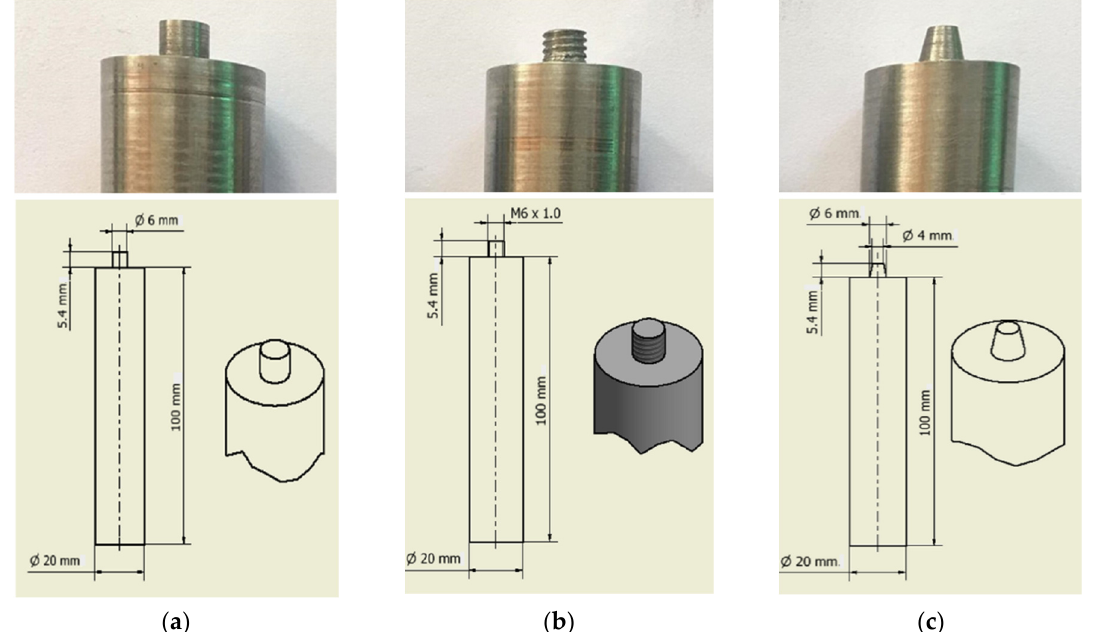
Figure 3. Tool profile for friction stir welding of SSM 5083 aluminum alloys: ( a ) straight cylindrical; ( b ) threaded cylindrical; ( c ) tapered cylindrical.